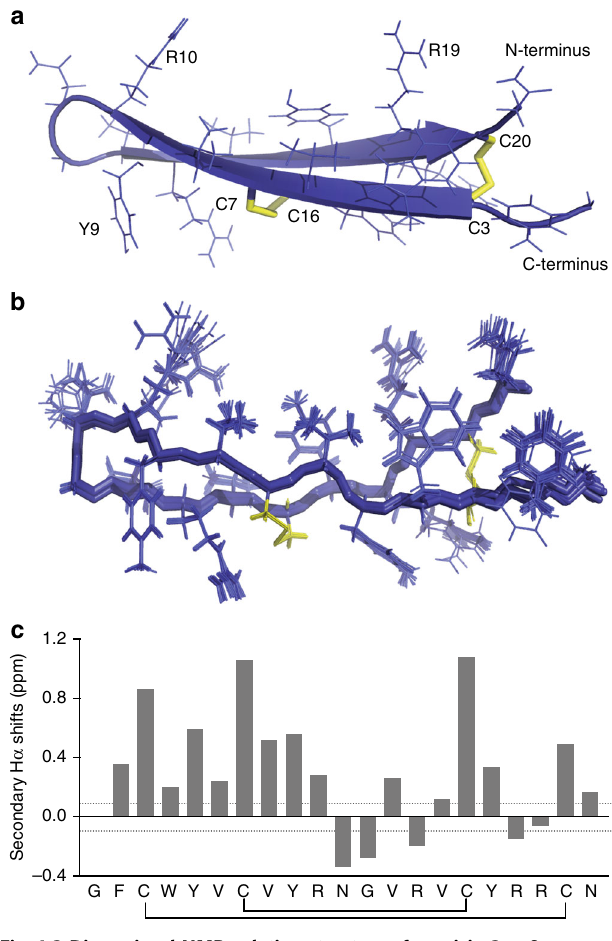
Fig. 1 3-Dimensional NMR solution structure of arenicin-3. a Structure displayed in cartoon form showing the classic β -hairpin assembly created by anti-parallel β -sheets and two stabilizing disul fi de bonds (yellow) across the sheet, key residues and the N and C terminus labeled for orientation. b Overlay of 20-lowest energy structures, aligned by backbone. c Secondary H α shifts (variation from random coil). Structure deposited as PDB 5V0Y and BMRB 30259 and images created using PyMol. Structural re fi nement statistics are displayed in Table